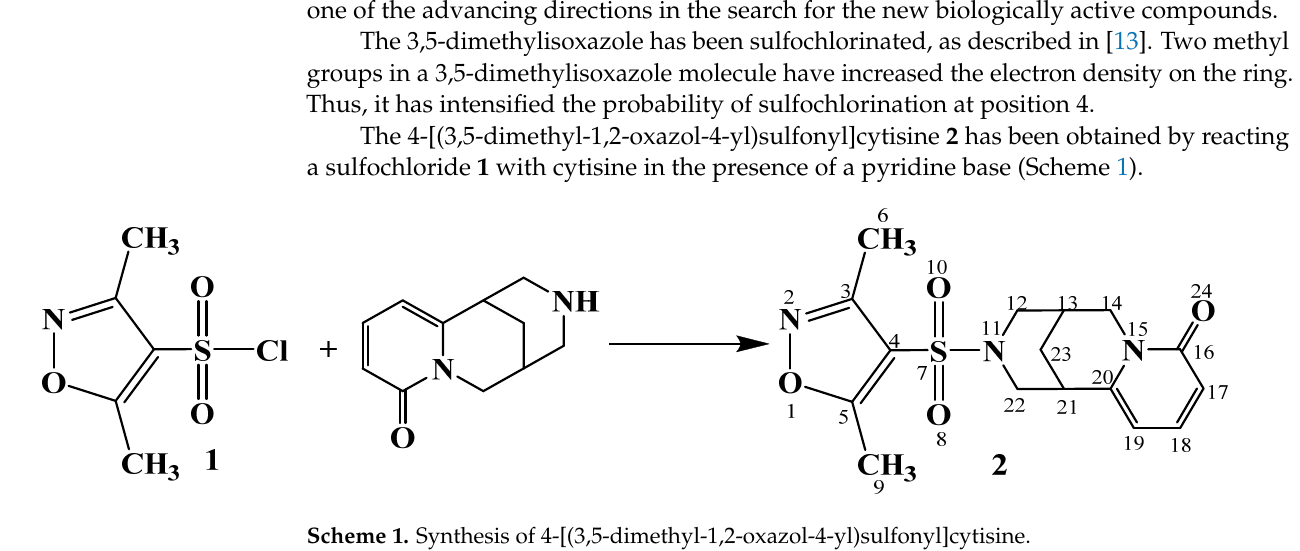
troscopy (Figure S1, Supporting Information) and mass spectrometry (MS) (Figure S11, Supporting Information).